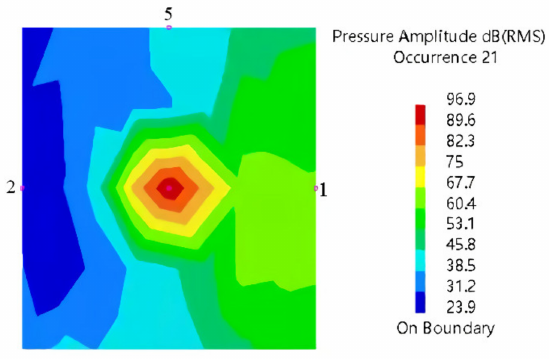
Figure 10. Vertical sound pressure cloud image.